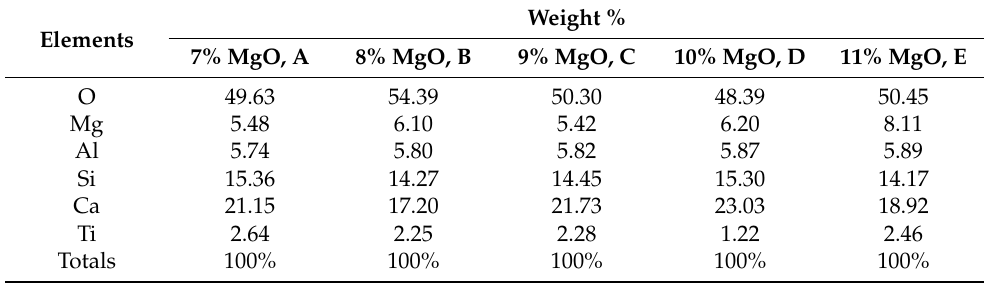
Table 4. SEM-EDS results of BF slag with different contents of